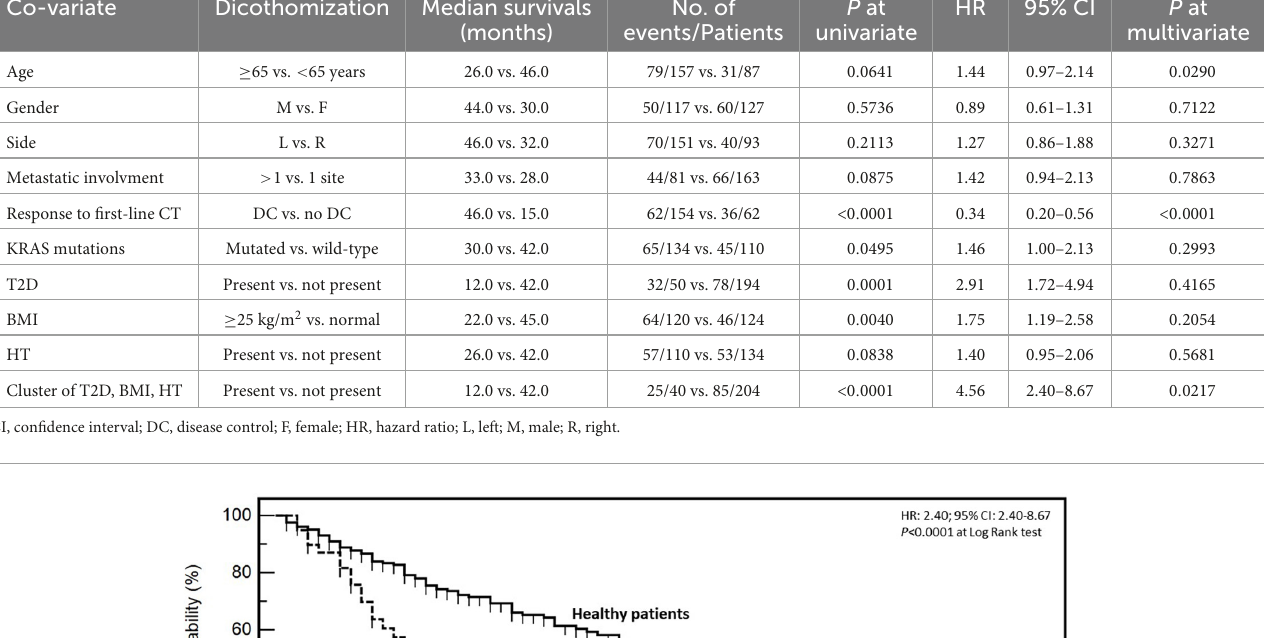
TABLE 4 Uni- and multivariate analysis of prognostic power of clinical characteristics and metabolic syndrome components in metastatic CRC patients. Co-variate